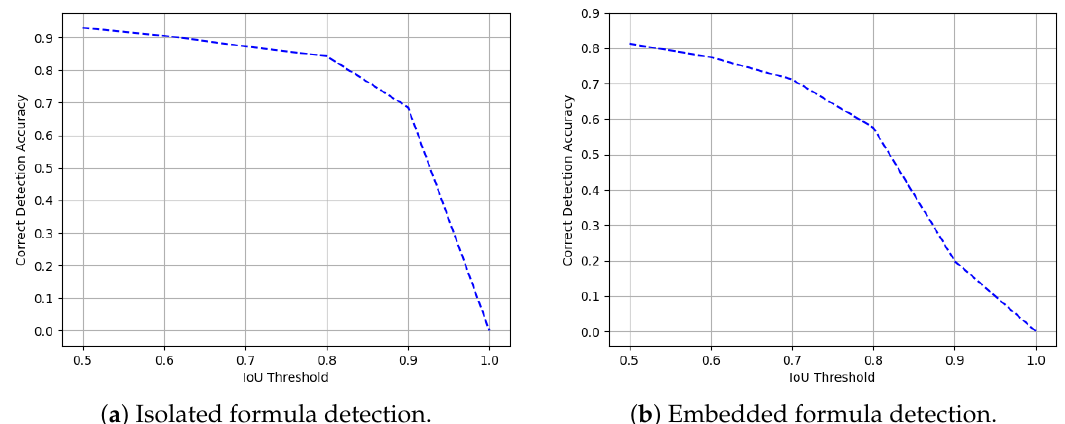
( a ) Isolated formula detection. ( b ) Embedded formula detection. Figure 11. Correct detection accuracy achieved on varying IoU threshold ranging from 0.5 to 1.0 on the Marmot dataset. ( a ) depicts the correct detection accuracy on isolated formulas, whereas ( b ) demonstrates the correct detection accuracy on embedded